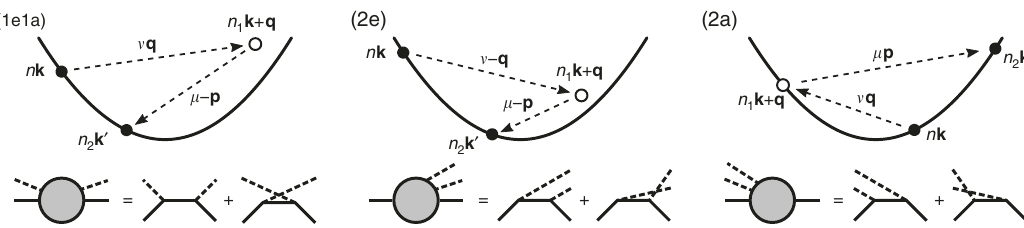
Fig. 2 Electron-two-phonon scattering processes. Two-phonon scattering processes considered in this work, including one-phonon absorption plus one- phonon emission (left panel, labelled 1e1a), two-phonon emission (middle panel, labelled 2e) and two-phonon absorption (right panel, labelled 2a). Each of these three processes comprises two interfering scattering channels, only one of which is shown in the band structure schematics. The lower panels show the corresponding Feynman diagrams with two external phonon lines. Note that the intermediate state does not need to be on-shell; of the three processes shown here, only the 2a is The process-resolved 2ph scattering rates are de fi ned as